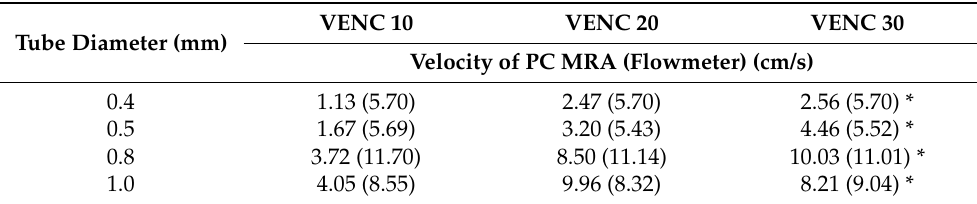
Figure 5. Comparison of flow velocities measured by 2D PC MRA with different velocity encodings (VENCs). Table 6. Flow velocities measured by 2D PC MRA with VENCs of 10 cm/s, 20 cm/s, and 30 cm/s and a flowmeter.